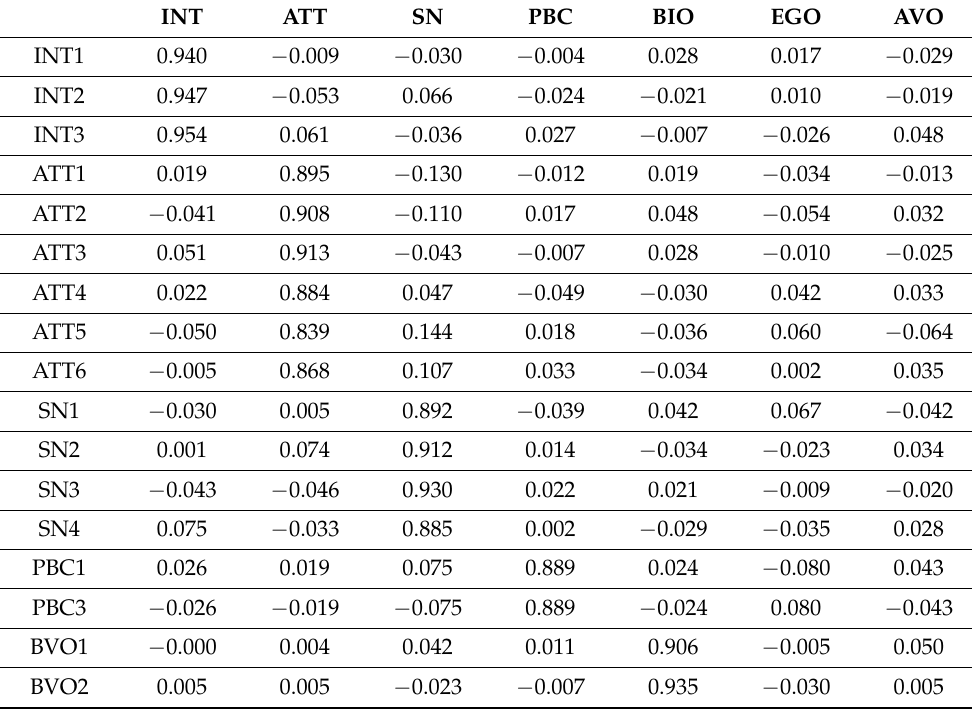
Table 3. Combined loadings and